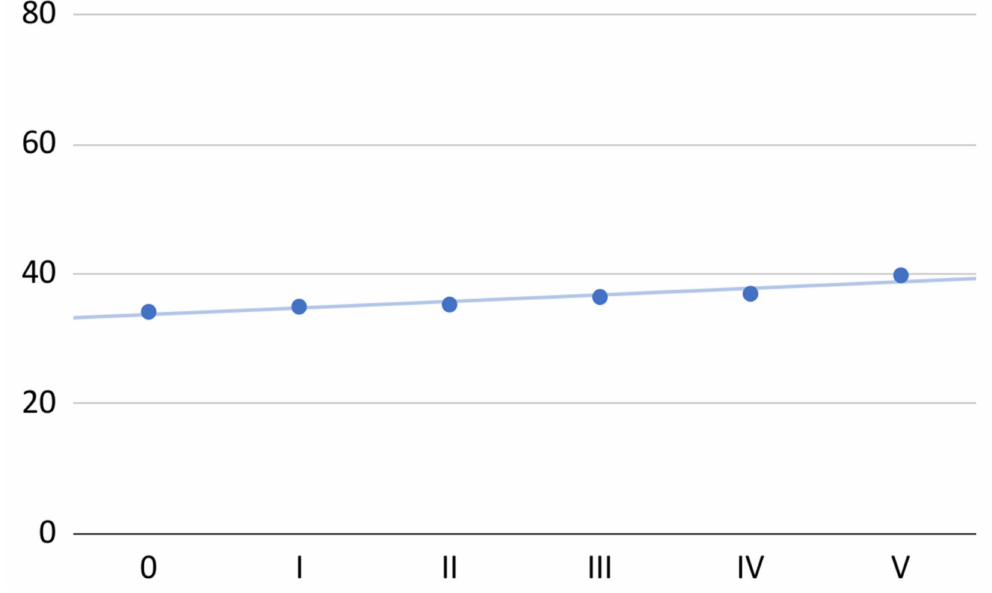
Figure 3. Mean painless mandible abduction at individual